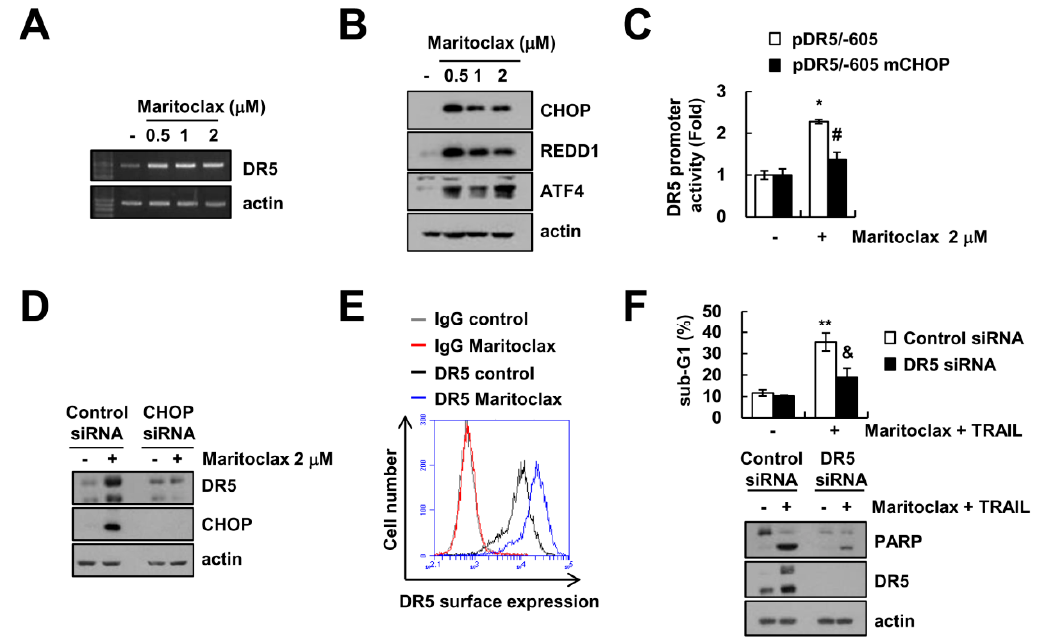
Figure 3. Maritoclax induces CHOP-mediated DR5 upregulation in Caki cells. ( A , B ) Caki cells were treated with indicated concentrations of maritoclax for 24 h ( A ) or 9 h ( B ). The mRNA level of DR5 was determined by RT-PCR ( A ). The protein expressions were determined by Western blotting ( B ). ( C ) Caki cells were transiently transfected with a plasmid harboring the luciferase gene under the control of the DR5/-605 and DR5/-605 mutant CHOP (mCHOP) promoter. After transfection, cells were treated with 2 µ M maritoclax for 24 h, and the luciferase activity was analyzed. ( D ) Caki cells were transfected with control or CHOP siRNA, and then cells were treated with 2 µ M maritoclax for 24 h. The protein expression levels were determined by Western blotting. ( E ) Caki cells were treated with 2 µ M maritoclax for 24 h. The cell surface expression level of DR5 was measured by flow cytometry analysis. ( F ) Caki cells were transiently transfected control siRNA or DR5 siRNA, and then cells were treated with 50 ng/mL TRAIL plus 2 µ M maritoclax for 24 h. Apoptosis was analyzed as a sub-G1 population by flow cytometry. The protein levels were determined by Western blotting. − , no treatment; +, treatment. The values in graph ( C , F ) represent the mean ± SD from three independent samples. * p < 0.01 compared to the control. # p < 0.01 compared to 2 µ M maritoclax-treated pDR5/-605. ** p < 0.01 compared to the control & p < 0.01 compared to the maritoclax plus TRAIL-treated control siRNA by ANOVA and Student-Newman-Keuls methods.